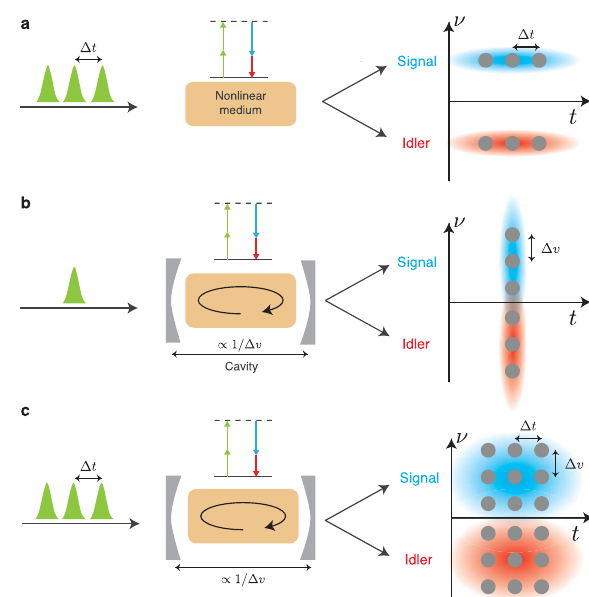
Figure 3: Scheme for the generation of time – frequency hyper- entanglement. (a) An optical pulse train composed of three pulses excites a nonlinear medium, where photon pairs (signal and idler) are generated through SFWM in a superposition of three time modes, given by the number of pulses. This results in a three-level time-bin entangled two-photon state. (b) A single pulse excites a nonlinear medium placed inside a cavity, where photon pairs are created in a superposition of three spectral modes, given by the number of selected cavity resonances per photon. This leads to a three-level frequency-bin entangled state. (c) Merging the concepts of (a) and (b), an optical pulse train excites a nonlinear cavity, thus generating a photon pair which is simultaneously entangled in time and fre- quency (i.e., a three-level hyper-entangled two-photon state). Adapted from